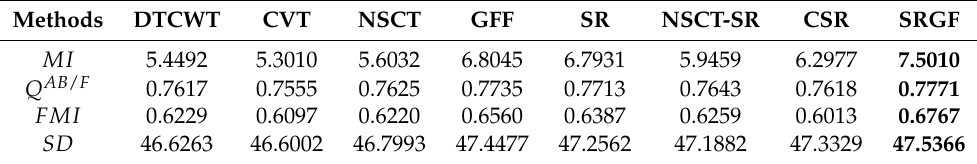
Figure 11. Fusion of “puppy” images. Table 3. Quantitative assessments of “puppy”